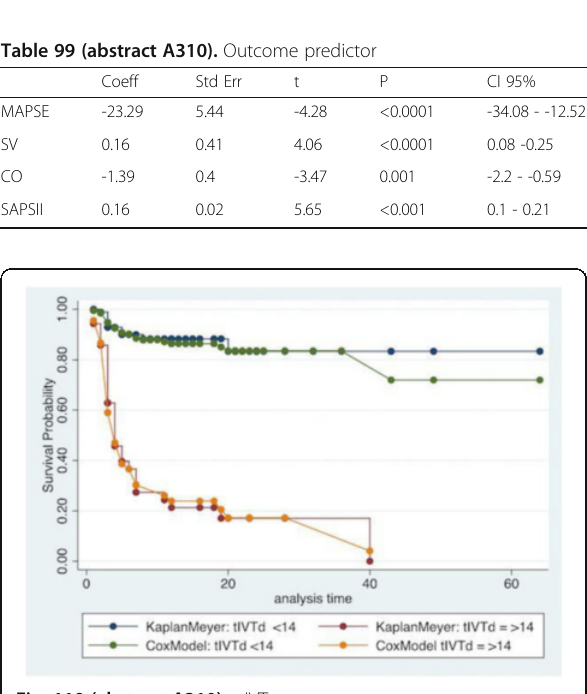
Fig. 119 (abstract A310). t-IVT